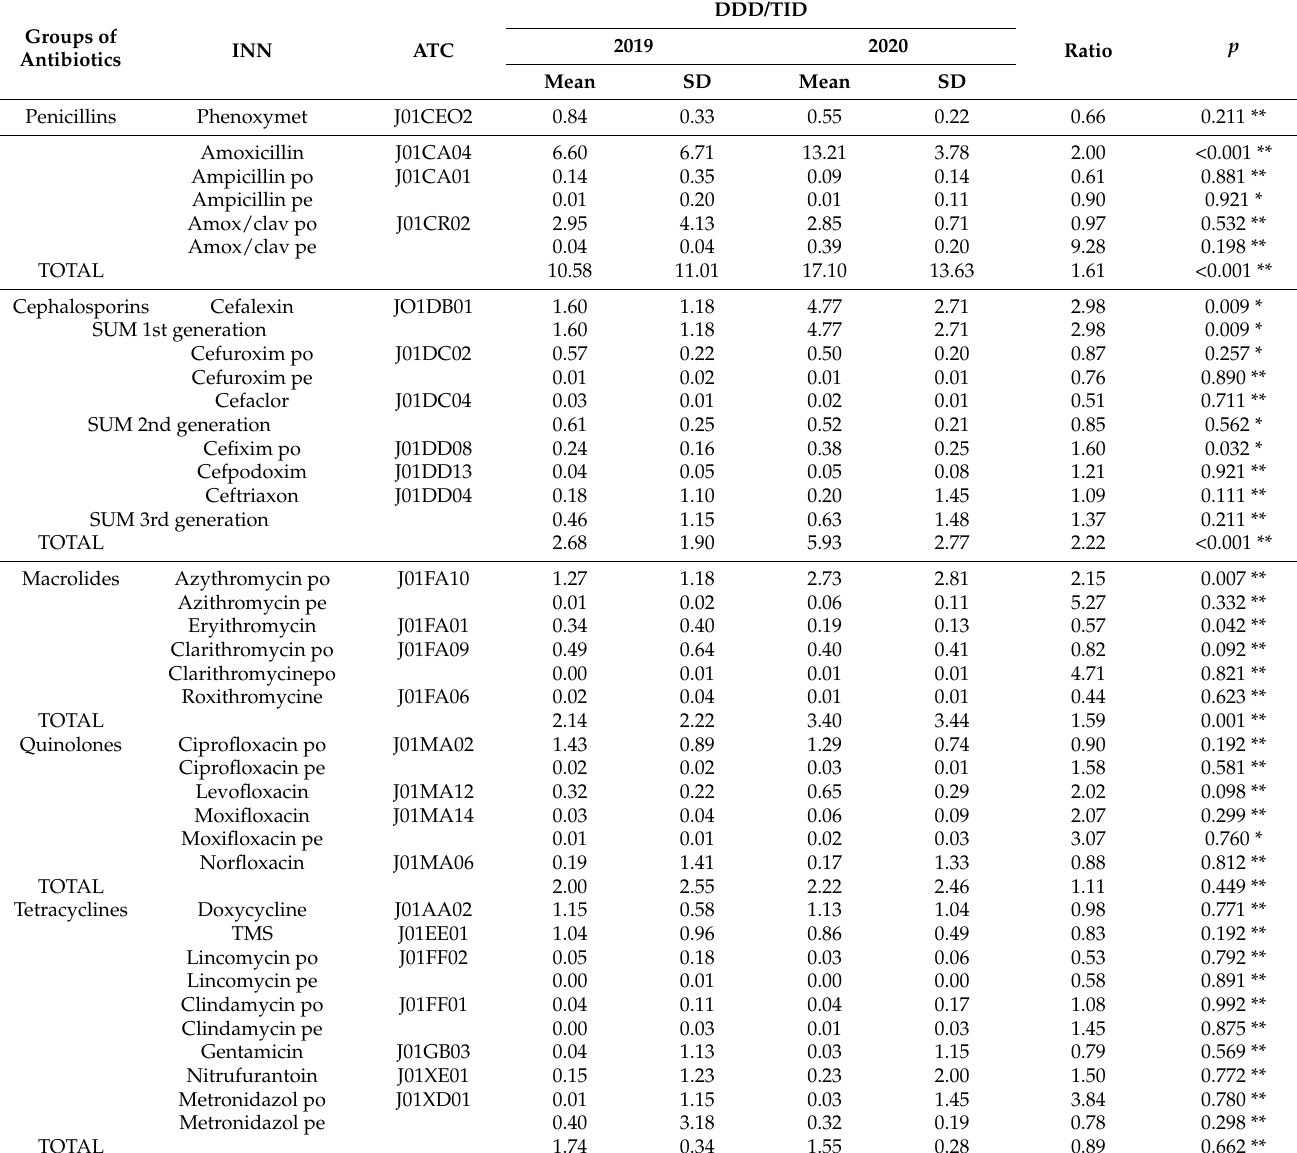
Table 2. Defined daily dose per 1000 inhabitants and the DID/TID ratio in 2019 and 2020 of consumption of antibiotics for systemic use (J01) before (2019) and during the pandemic period (2020) in RS.